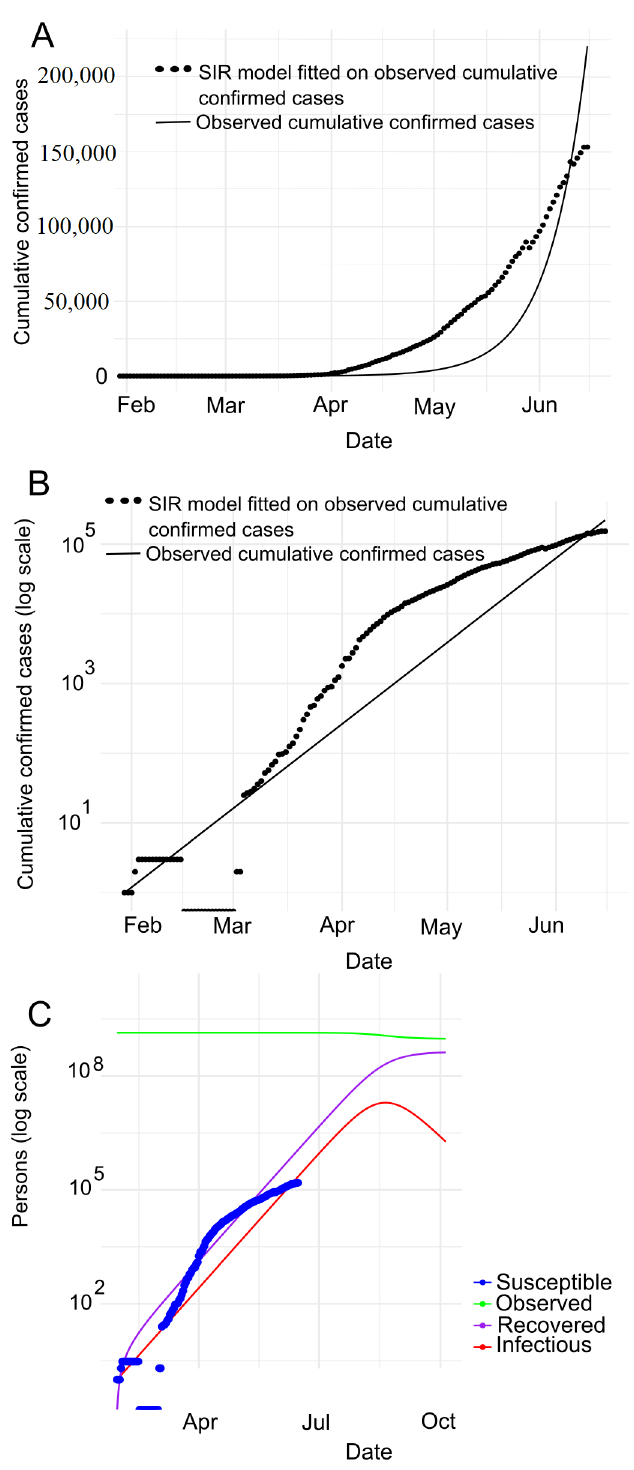
Figure 5. Prediction with SIR model for India: ( A ) SIR model fitted on observed cumulative infected cases ( B ) SIR model fitted on observed cumulative infected cases with semi log scale ( C ) SIR model prediction with no human